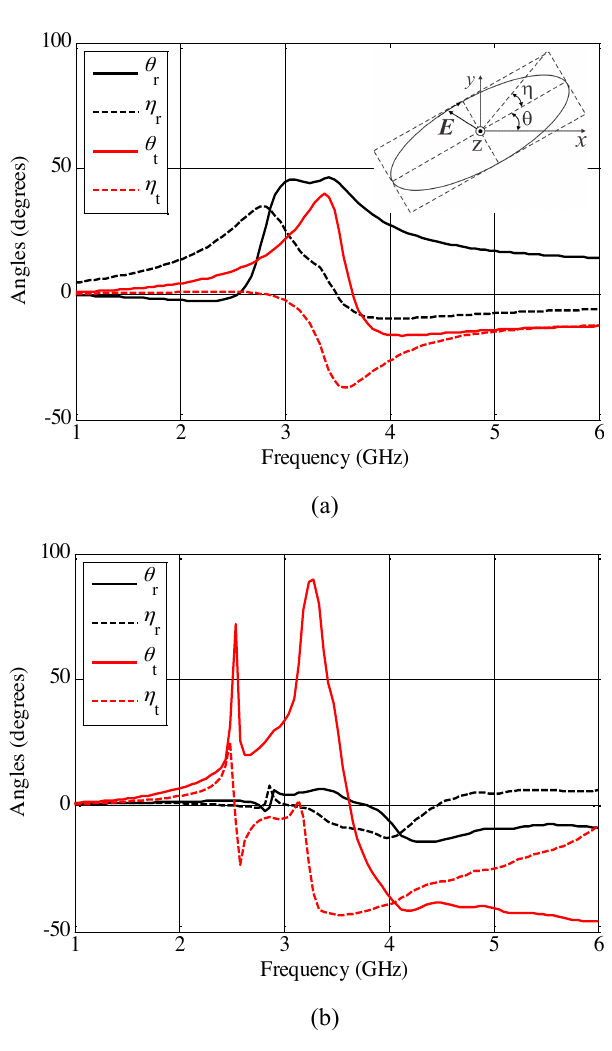
Figure 5. Azimuth θ and ellipticity η angles of waves reflected from and transmitted through ferrite substrate without metalization (a) and through the structure with magnetization in z -direction; ω /2 π = 3,5 GHz. 0